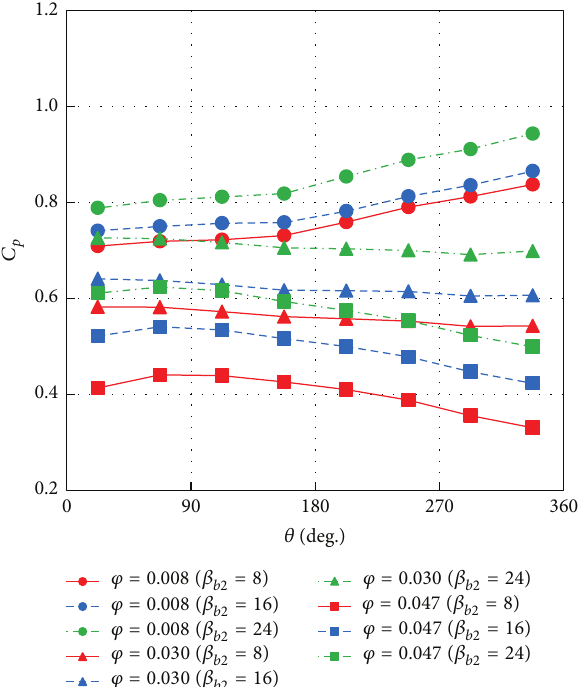
Figure 15: Circumferential direction distributions of time-averaged pressure coefficient ( 𝐶 𝑃